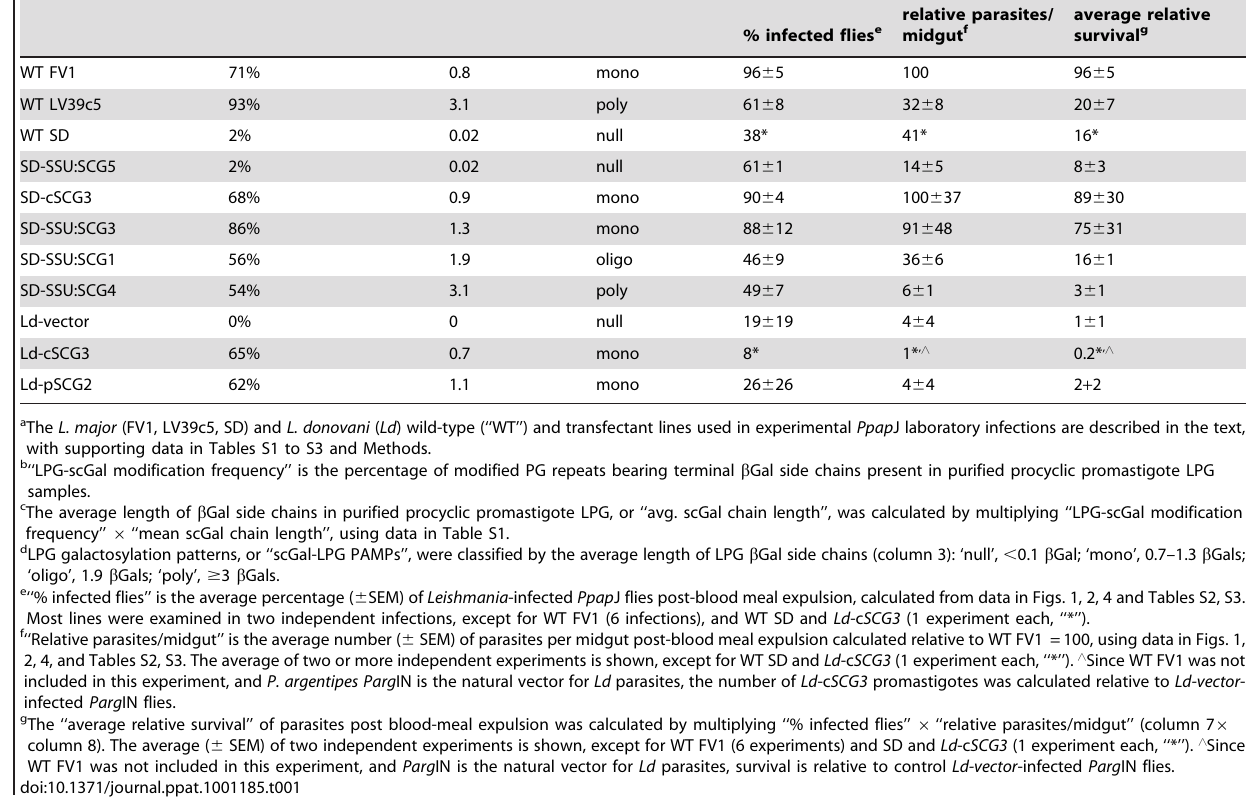
Leishmania line